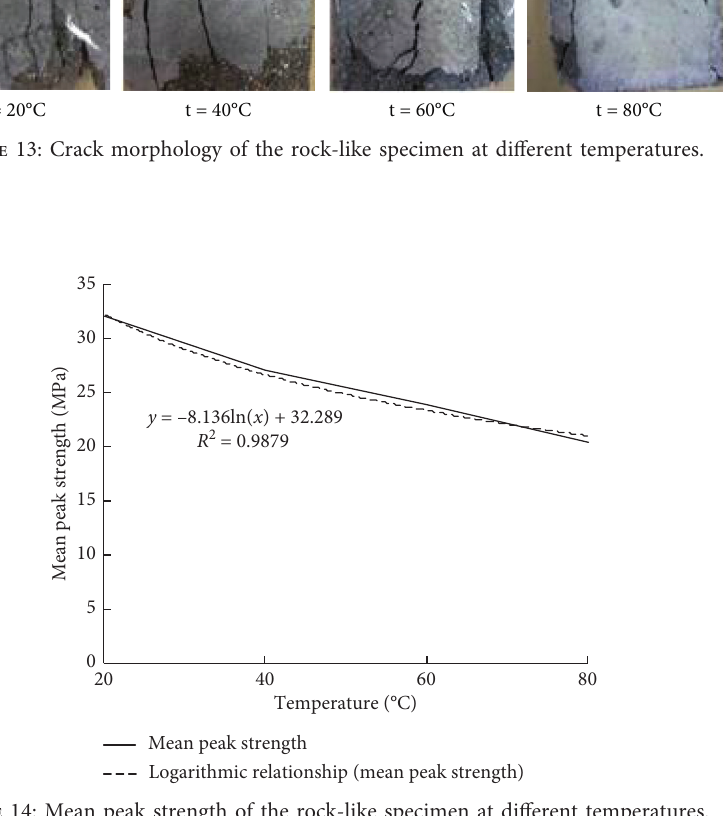
Figure 14: Mean peak strength of the rock-like specimen at different temperatures.